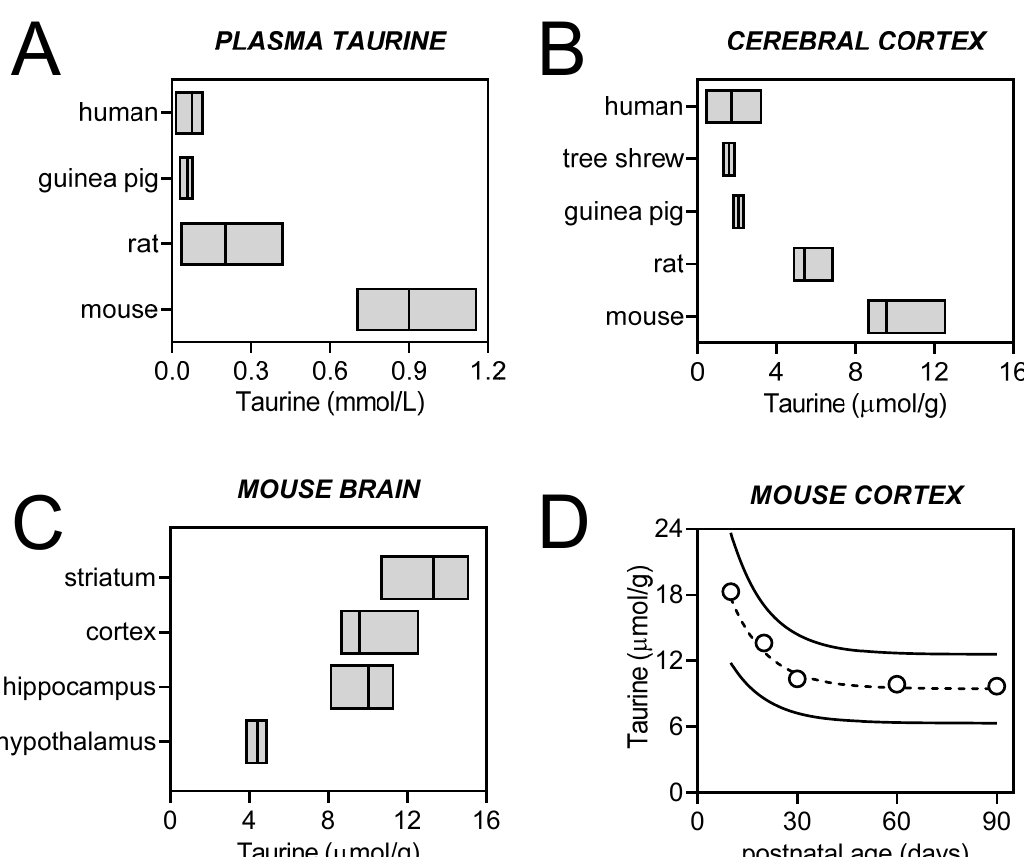
Figure 2. Concentrations of taurine in the plasma ( A ) and cerebral cortex of various species ( B ), in different areas of the mouse brain ( C ), and in the mouse cortex during development ( D ). Plasma taurine levels are indicated as mean and range for humans [2,20–27], guinea pigs [28,29], rat [30–36], and mice [37–41]. The plotted brain taurine concentration ranges are based on the concentra ‐